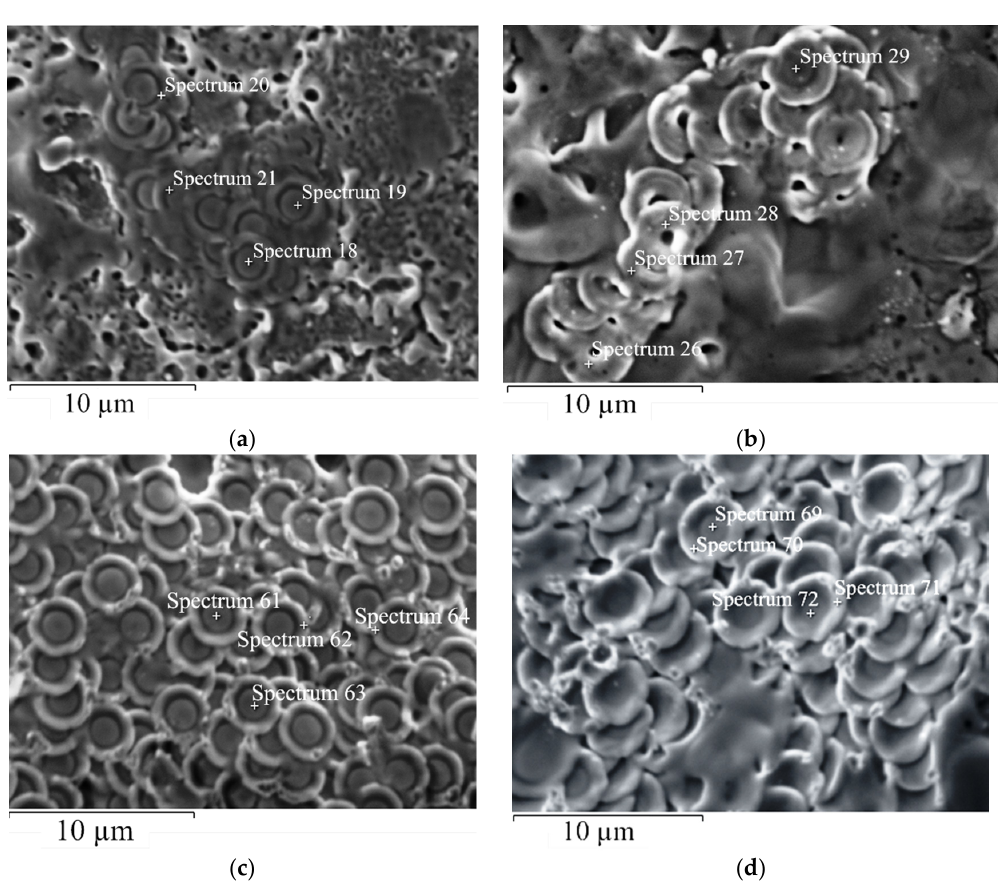
Figure 5. SEM images collected for the coatings on the working surface of RS blades after the commutation tests with I c = 0.4 A and different numbers of switching cycles N : ( a ) cathode, N = 10 3 ; ( b ) anode, N = 10 3 ; ( c ) cathode, N = 10 6 ; ( d ) anode, N = 10 6 . Crosses and inscriptions on the panels indicate the position of EDXA measurements.